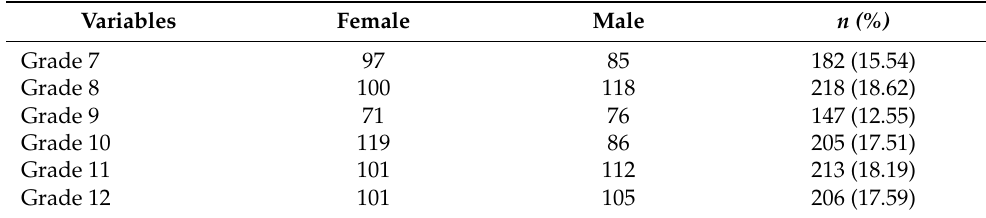
Table 1. Demographic information about the